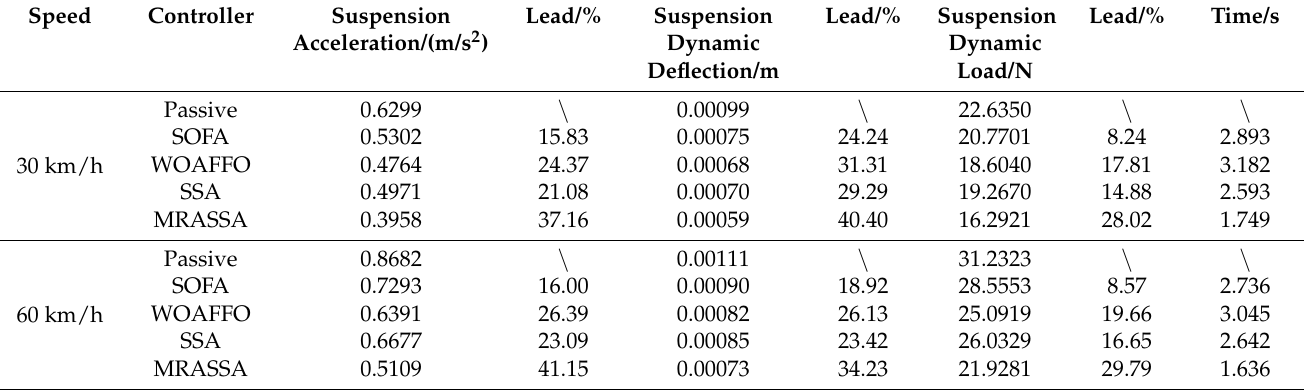
Table 4. Optimization Results for Simulation of the Random Road.